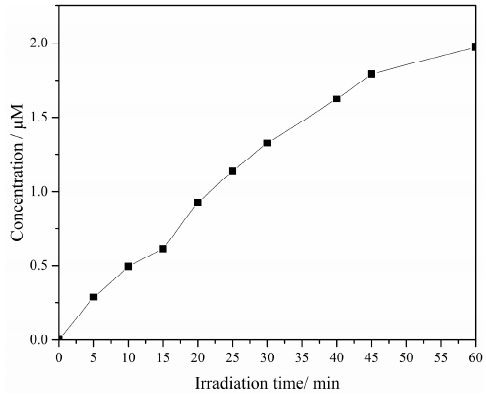
Figure 9. Amount of the produced 2-hydroxyterephthalic acid from the UV(A)-irradiated suspension of terephthalic acid and K-7000.